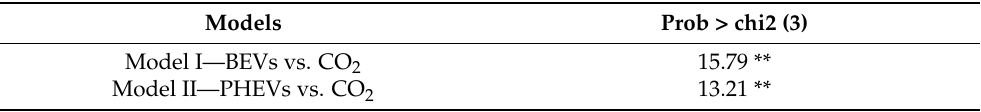
Table 8. Hausman test.